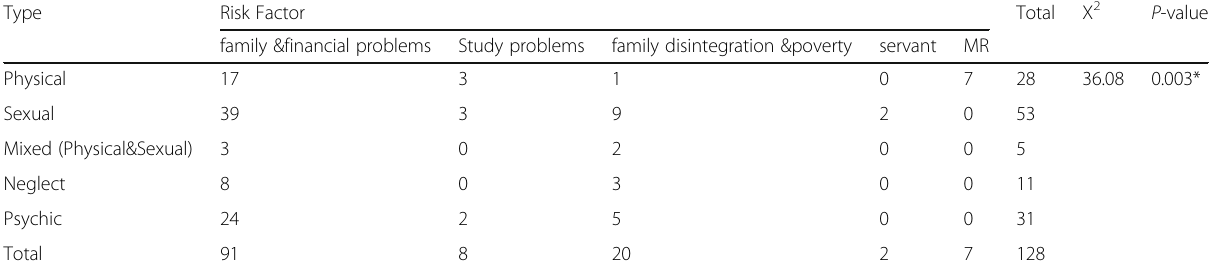
Table 5 Relation between risk factor and type of violence among the studied cases Type